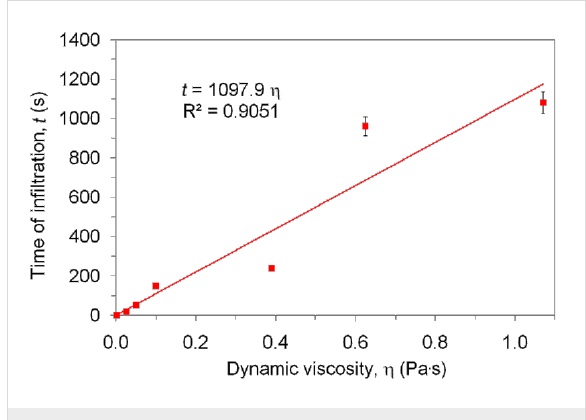
Figure 3: Time of infiltration of HACNTs film as a function of the dynamic viscosity of a range of viscous liquids.